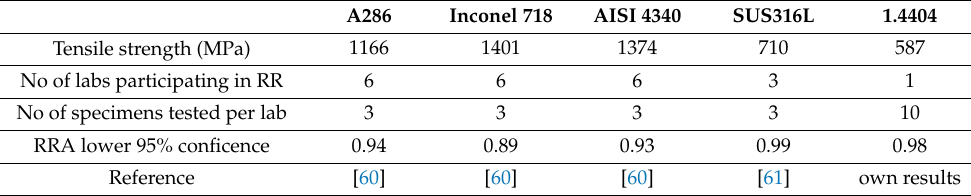
Table 2. Results of repeatability and reproducibility studies of tensile tests in ambient control atmospheres (helium, nitrogen or air). RR = round robin.